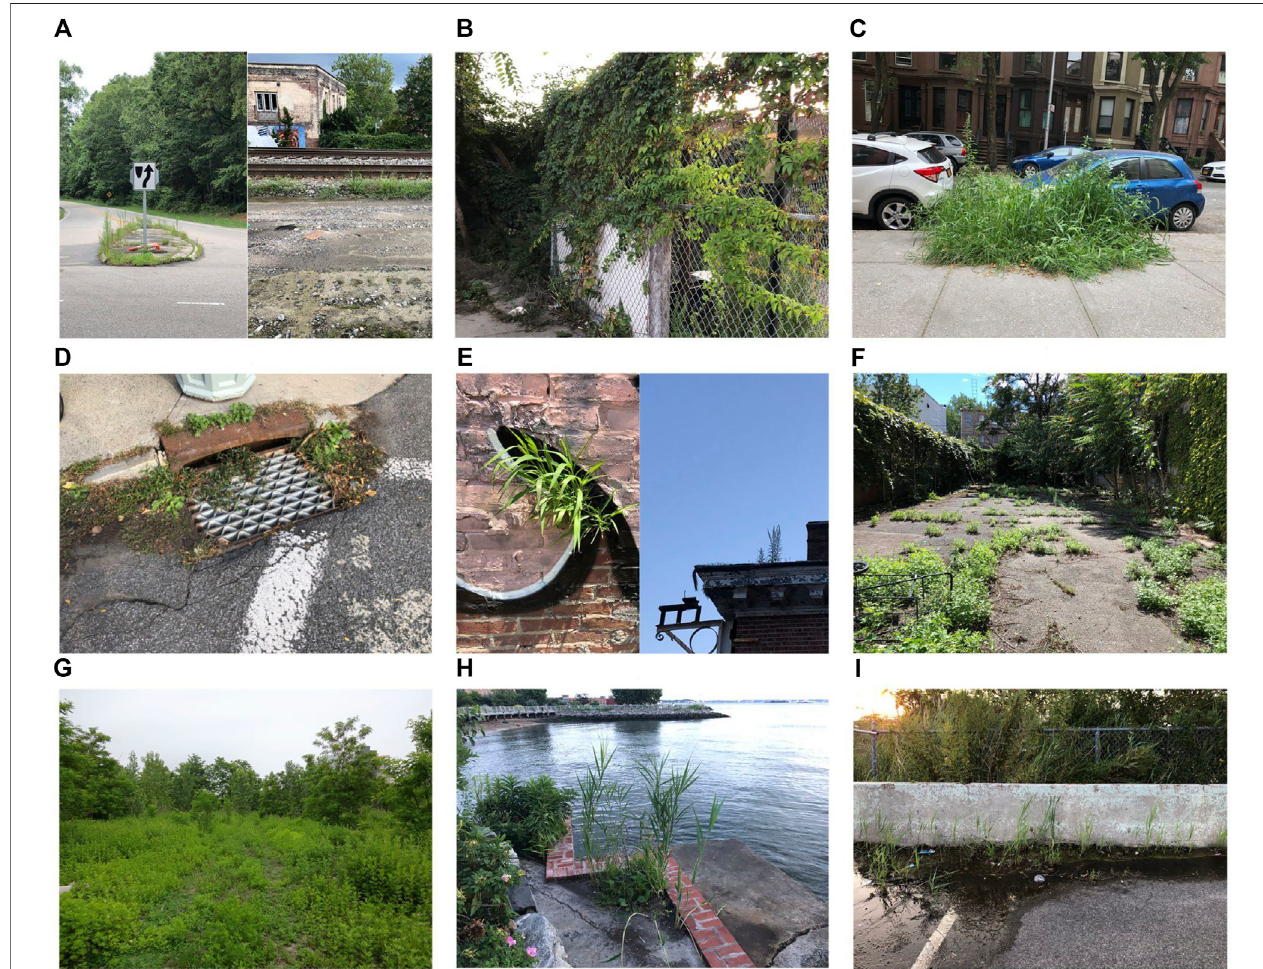
FIGURE 1 | Common ruderal habitats in New York City. (A) Ruderway, urban plant communities located near roadways or transportation corridors (Monocots, annuals, herbaceous perennials, deciduous shrubs, semi evergreen vines, and deciduous wood vines); (B) Vertical Support Structures, located on fences, gates, walls and other human-made infrastructures (semi evergreen vines, deciduous wood vines, and climbing shrubs); (C) Urban Fissures, urban plants that thrive in the gaps, holes, cracks, rifts and openings of impervious surfaces (herbaceous perennials, monocots, prostrate, summer annuals, herbaceous biennial, and Therophytes); (D) Storm Drain Ruderal Basins, found in and around storm drainage systems (herbaceous perennials, prostrate, and summer annuals); (E) Urban Epiphytes, urban plants that grow on, out of, or around rooftops and vertical infrastructures (Winter or summer annuals); (F) Living Lots, vacant or underutilized land parcels that support urban plant communities (Wood dicots, multi stemmed shrubs, summer and winter annual, herbaceous perennial, deciduous tree, and monocots); (G) Postindustrial Meadow or Forest, disturbed postindustrial landscapes (Deciduous trees, conifer, monocots, annual, herbaceous perennial, winter and summer annuals); (H) Weedy River and Coastal Embankments, disturbed aquatic and coastal habitats (sea walls, docks, retaining walls, and natural features) (herbaceous perennials, prostrate, summer annuals, monocots, and deciduous vine); (I) Parking Lot Lagoon, impervious areas such as parking lots that collect precipitation and support ruderal plants (herbaceous perennials, prostrate, summer annuals, monocots). Photos by Christopher Kennedy.